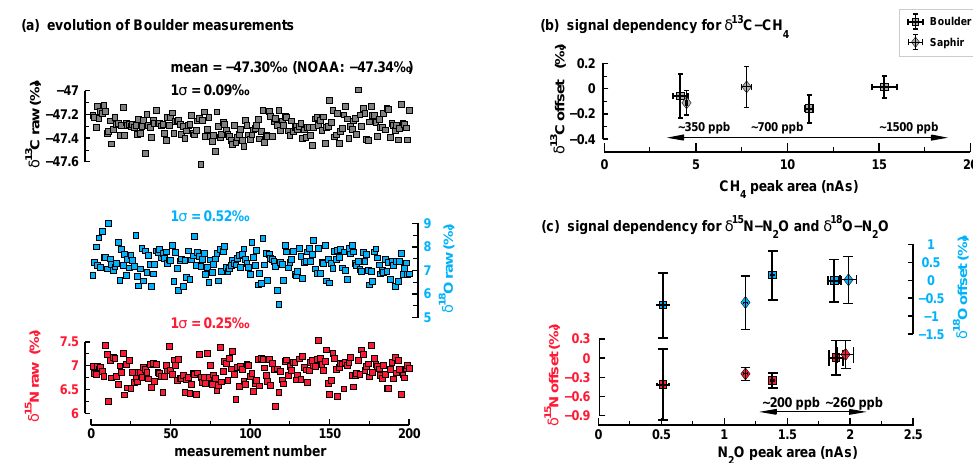
Figure 8. System performance of reference air measurements. (a) Long-term evolution of the measured raw values for the isotopic signatures ( δ 13 C, δ 15 N, δ 18 O) of “Boulder” air referenced against pure CO 2 and N 2 O on/off peaks spanning a period of 1 year. Effect of sample size and signal intensity on the measured isotope ratios (b) for δ 13 C–CH 4 and (c) for δ 18 O–N 2 O and δ 15 N–N 2 O. Within the range covered by ice core and ambient air samples, all three isotope ratios are independent of the signal